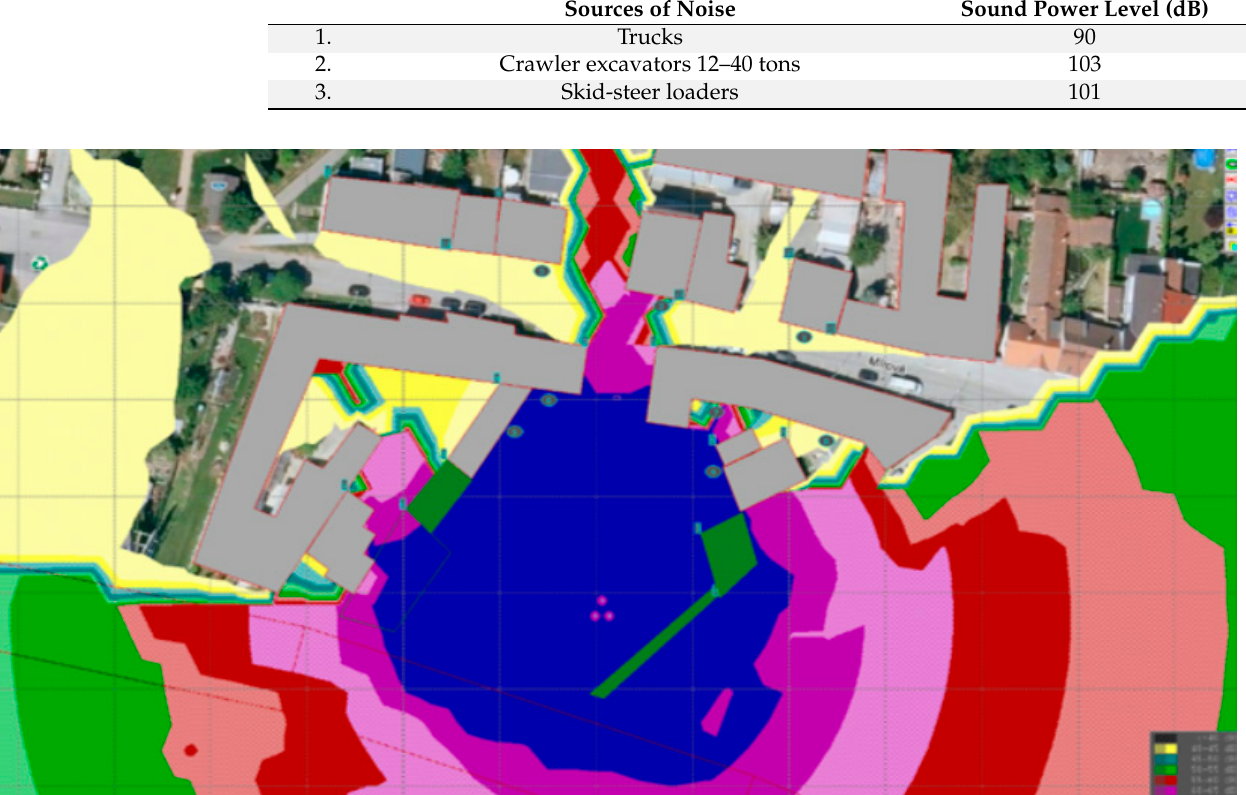
Table 11. Table of points from the calculation of measured points for earthworks in the investi- gated area.